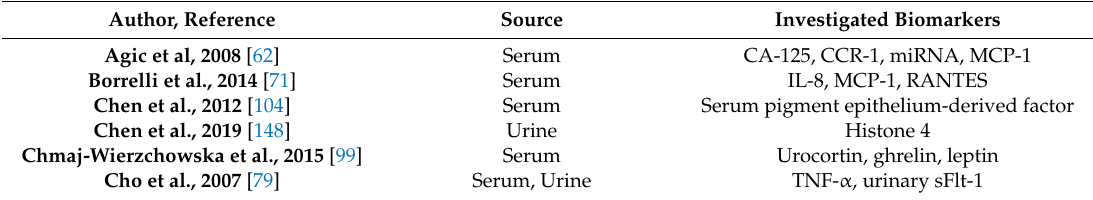
Table 2. Studies assessing the main noninvasive biomarkers for